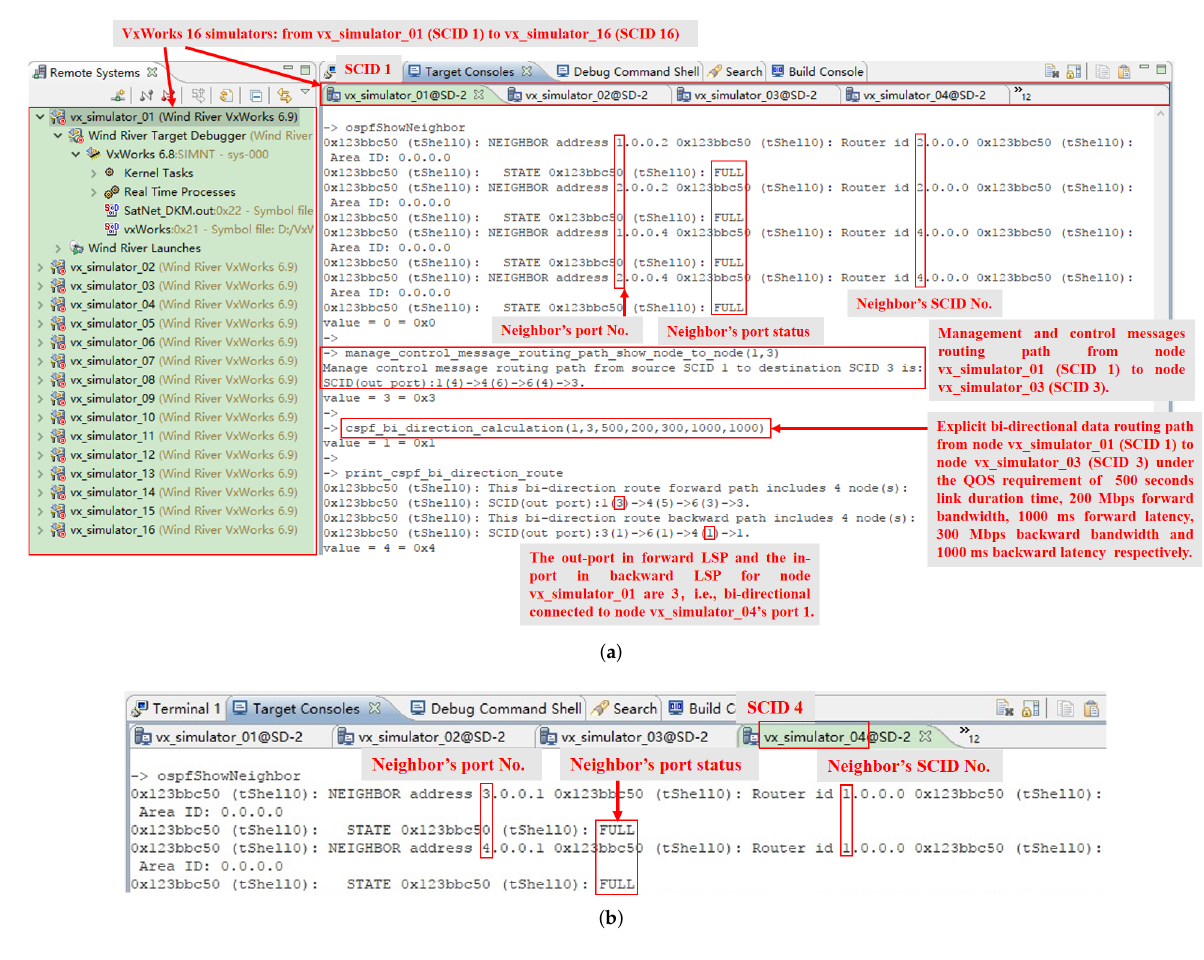
Figure 10. Simulation in software platform with 16 simulated nodes under the circumstances of bi-directional link. ( a ) The status of a neighbor’s ports, routing path for managing and controlling mes- sages, and explicit constraint routing path for data under QoS requirements in node vx_simulator_01 (SCID 1). ( b ) The status of a neighbor’s ports in node vx_simulator_04 (SCID 4). Table 2. A bi-directional label switching path under the circumstances of bi-directional link